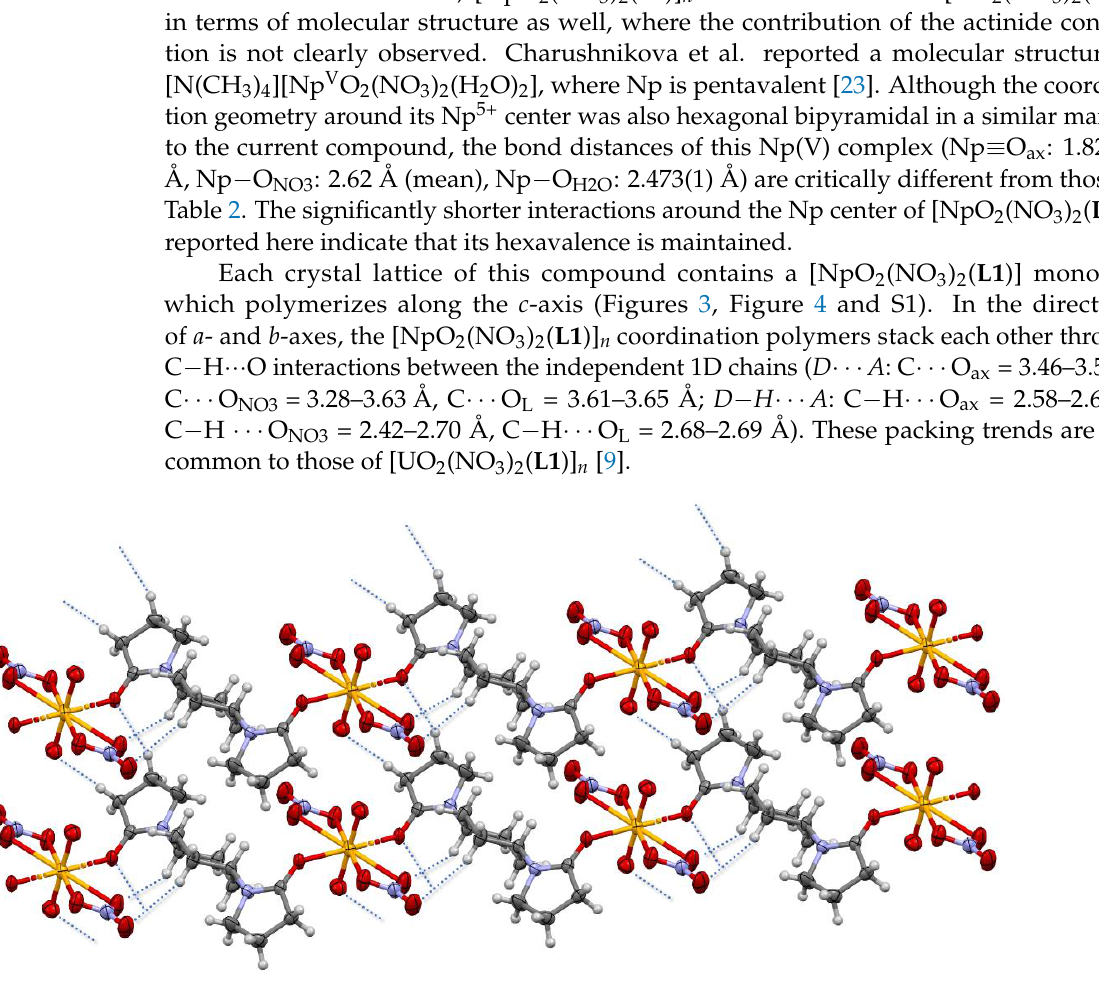
Figure 4. C−H···O interactions occurring in the crystal structure of [NpO 2 (NO 3 ) 2 ( L1 )] n . Although more interactions can be found there, only some of them are drawn with dotted lines here for clarity. Color codes, Np: yellow, O: red, N: purple, C: grey, H: white.